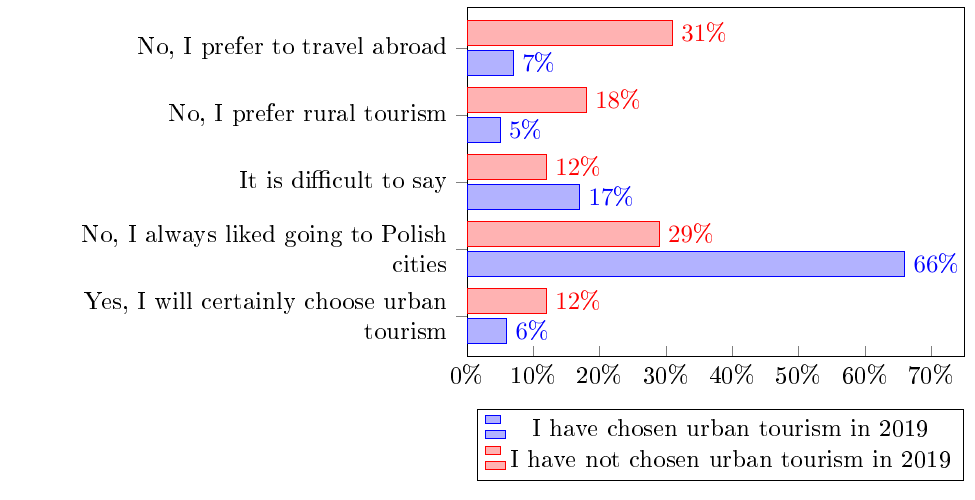
Figure 4: Preferences after a tourist trip during a